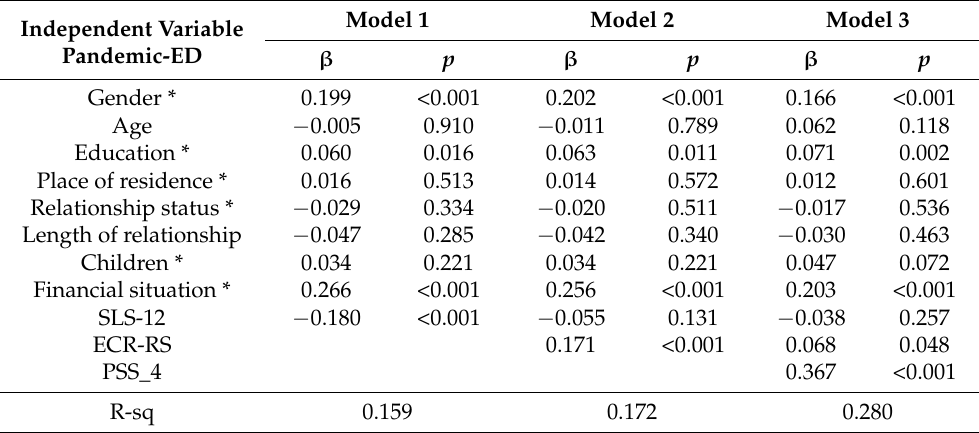
Table 7. Hierarchical regression for pandemic-related emotional difficulties. Variables in the model (N = 1405).